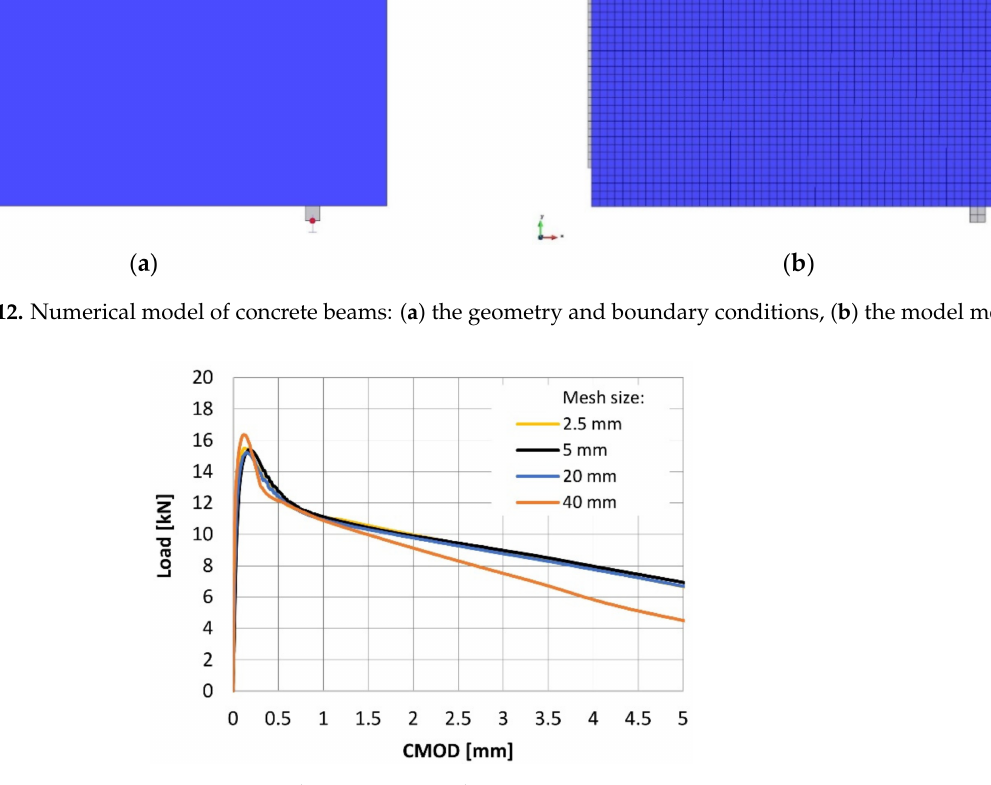
Figure 13. Mesh sensitivity